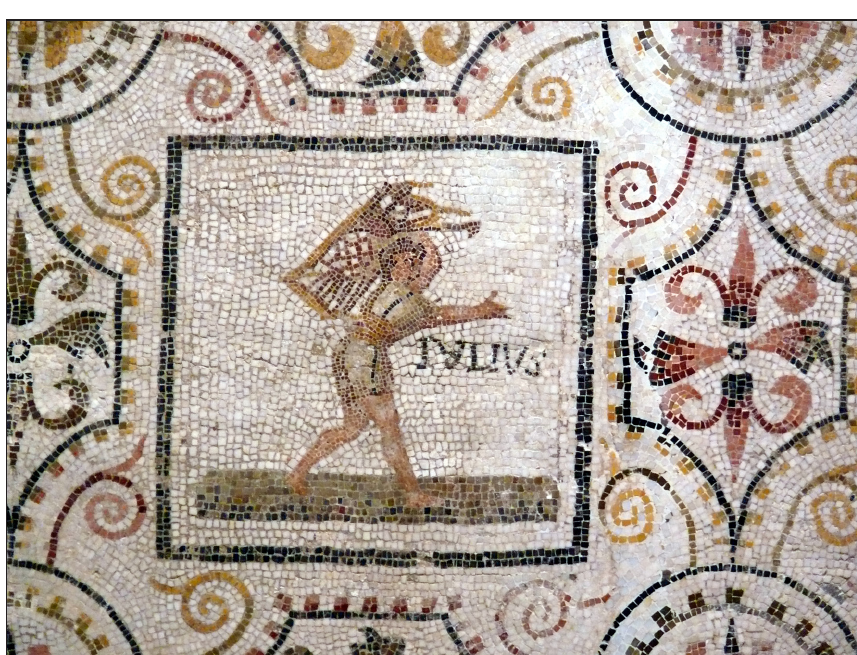
Figure 3: Portion of the Mosaic of the Months, El Djem (Sousse Museum), July. (Photo: Ad Meskens, licensed under Creative Commons Attribution-Share Alike 3.0 Unported License).